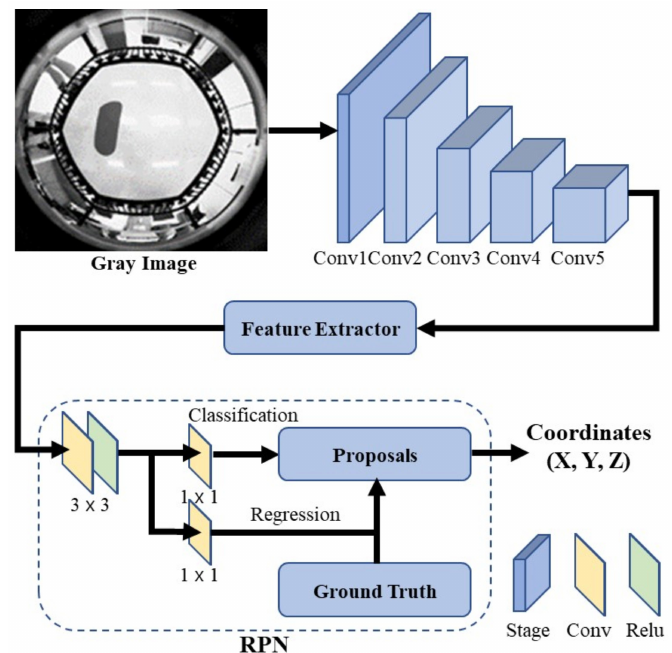
Figure 6. RPN in a Faster R-CNN for a 3DFPE-DL.